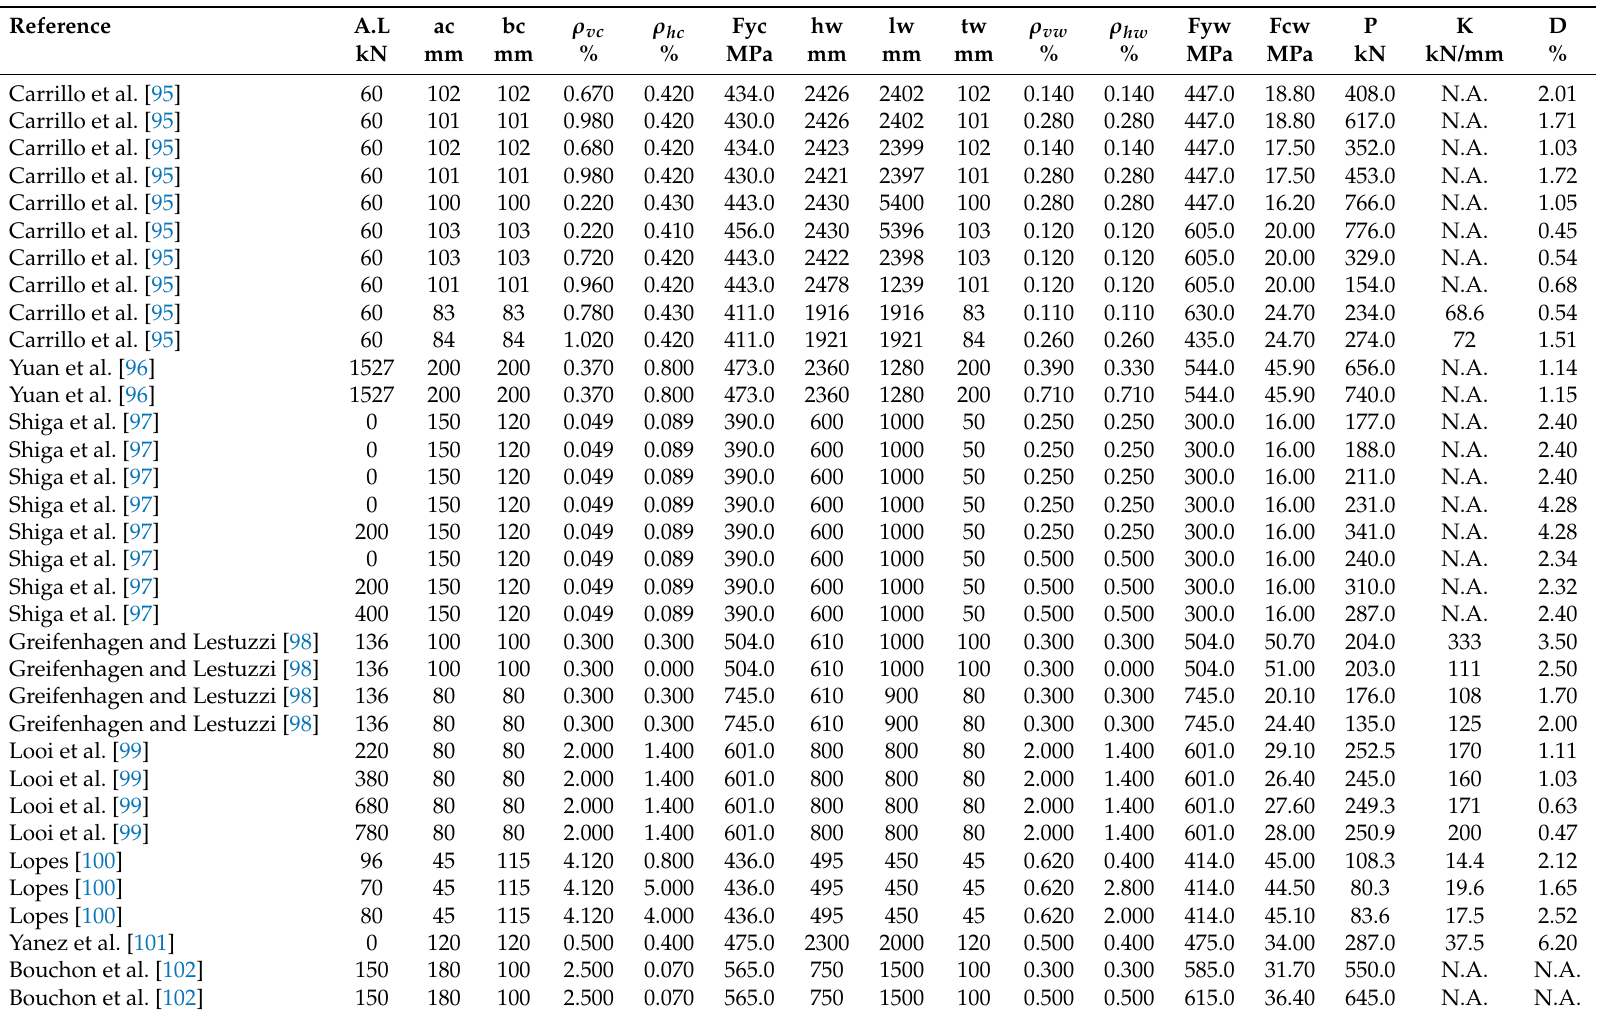
Table A2. Library of reinforced concrete shear walls